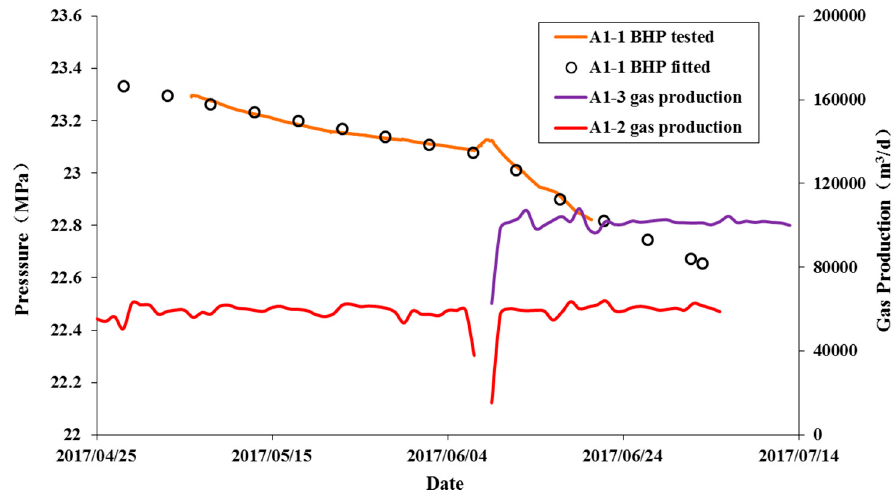
Figure 3. Double logarithmic curve fitting results for pressure recovery in well A1-1.